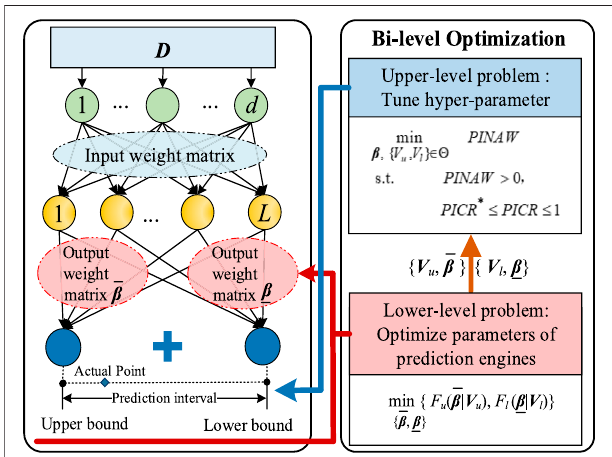
FIGURE 2 | Structure of the CIP